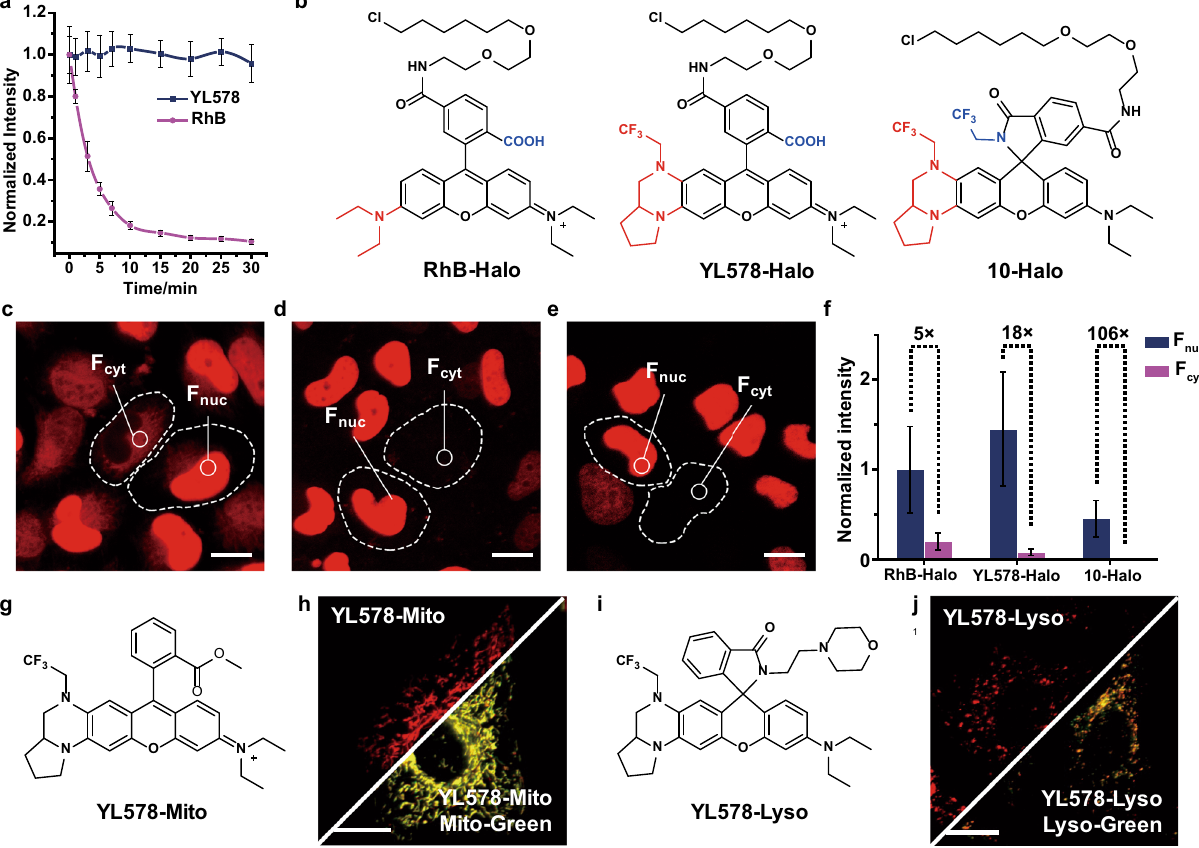
Fig. 3 Utility of YL derivatives in live-cell imaging. a Comparison of the photostability of 5 μ M YL578 or RhB in live HeLa cells with continuous irradiation at 560 nm in confocal microscopy. Error bars, ±s.e.m. 50 cells were examined in three independent experiments separately. b Structures of HaloTag ligands RhB-Halo, YL578-Halo , and 10-Halo . The moiety in red and blue indicate the difference between the three probes. Live-cell, no-wash confocal images (60×) of co-cultured H2B-HaloTag-expressing HeLa cells and wild-type HeLa cells with 250 nM RhB-Halo ( c ), YL578-Halo ( d ), and 10-Halo ( e ), the dashed lines represent the cellular boundary. f Fluorescence ratio ( F nuc / F cyt ) of RhB-Halo, YL578-Halo , and 10-Halo in live-cell confocal microscopy. Bar plot representing the normalized nuclear signal ( F nuc , H2B-Halo-expressed HeLa cells) and the cytosolic signal ( F cyt , wild-type HeLa cells). Fluorescence intensities were normalized to the nuclear signal of RhB-Halo. Error bars, ±s.e.m. 50 cells were examined in three independent experiments separately. g Structure of YL578-Mito . h Live-cell, no-wash confocal images of co-incubated HeLa cells with YL578-Mito and Mito-Green. i Structure of YL578-Lyso . j Live-cell, no-wash confocal images of co-incubated HeLa cells with YL578-Lyso and Lyso-Green. Scale bar, 20 μ